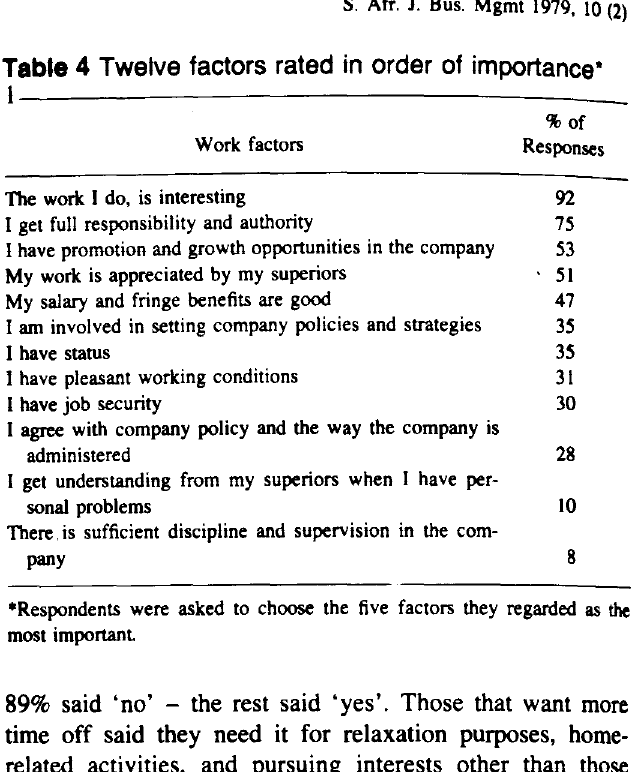
Table 4 Twelve factors rated in order of importance• 1 - - - - - - - - - - - - - - - - - -